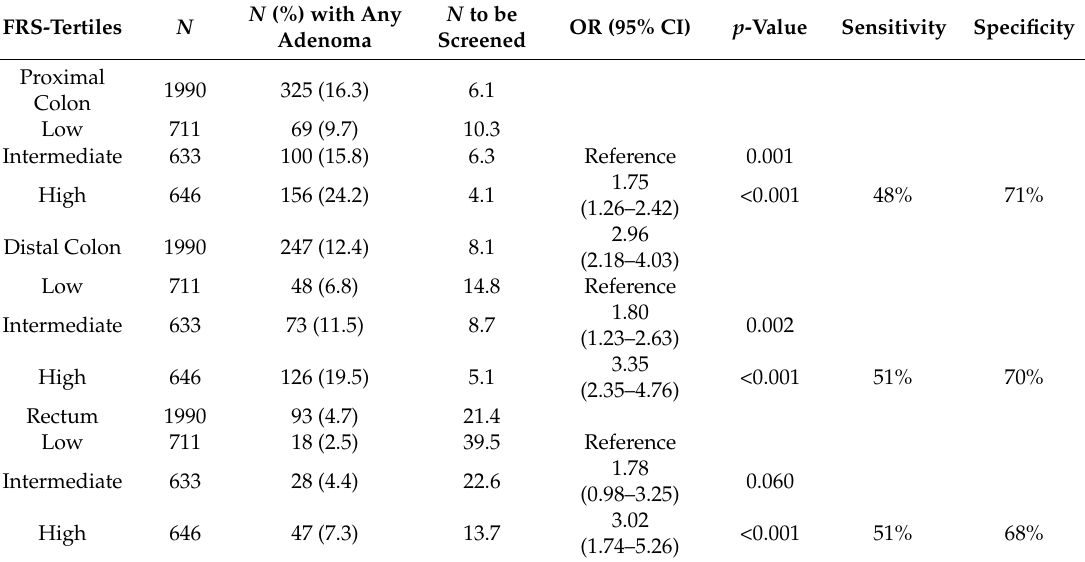
Table 5. Associations of the Framingham Risk (FRS) Tertiles with colorectal lesion, by location.